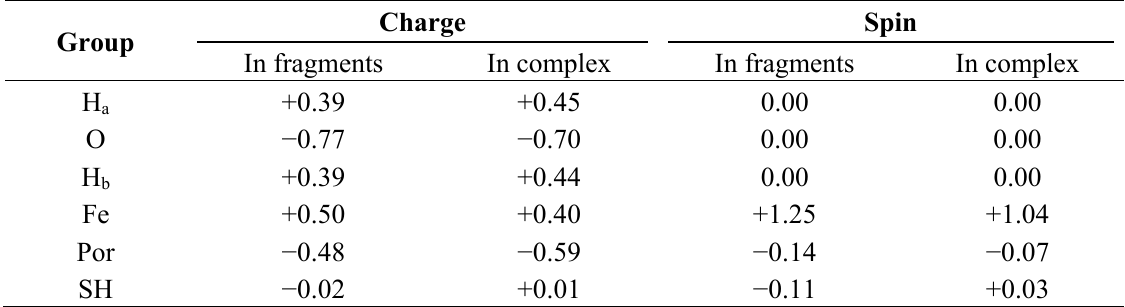
Table 3. Charges and spin populations of various groups in the fragments and complex of 1 .